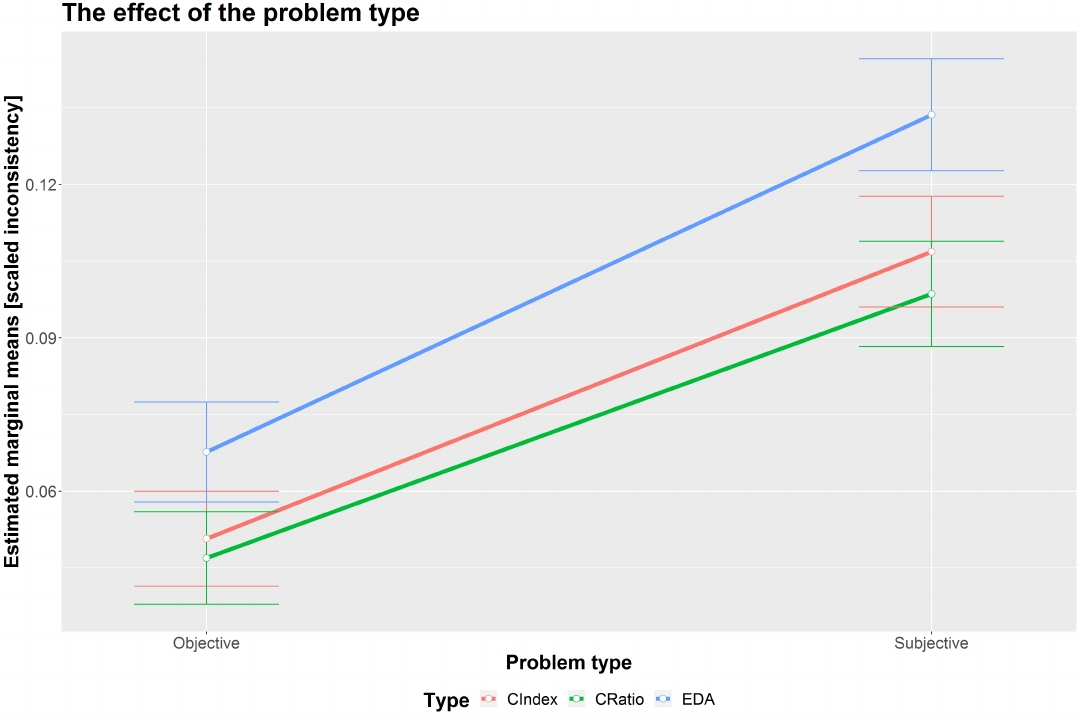
Figure 1. Estimated marginal means of scaled inconsistencies for selected inconsistency coefficients across different problem types. The error bars represent 95% confidence intervals. Scaling is based on the max–min